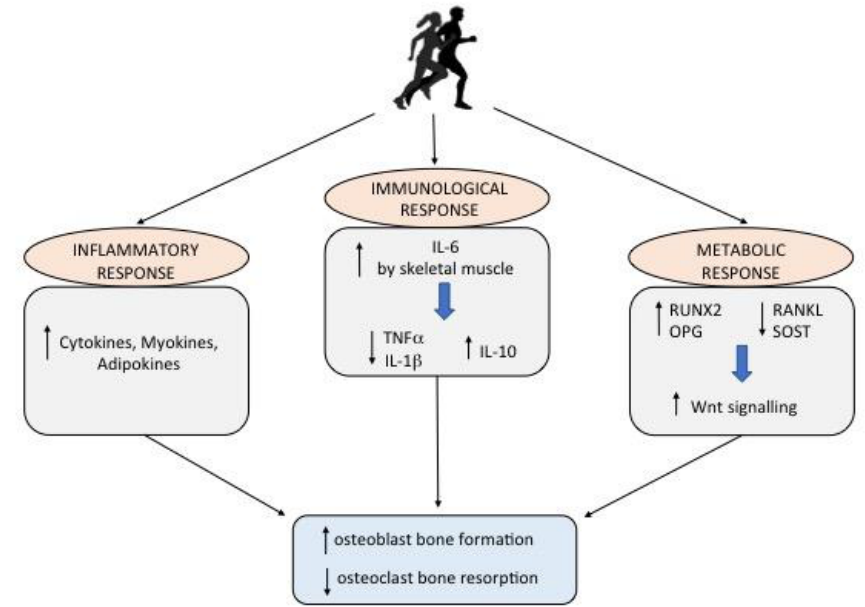
Figure 1. The impact of physical activity on bone health. Physical activity positively affects bone metabolism via different mechanisms: 1. activation of an inflammatory cascade involving cells of the metabolism via di ff erent mechanisms: 1. activation of an inflammatory cascade involving cells of innate and adaptive immunity and mediators of inflammation; 2. triggering an immunological the innate and adaptive immunity and mediators of inflammation; 2. triggering an response due to the increase of IL-6 by skeletal muscle; 3. stimulation of the Wnt signaling pathway.